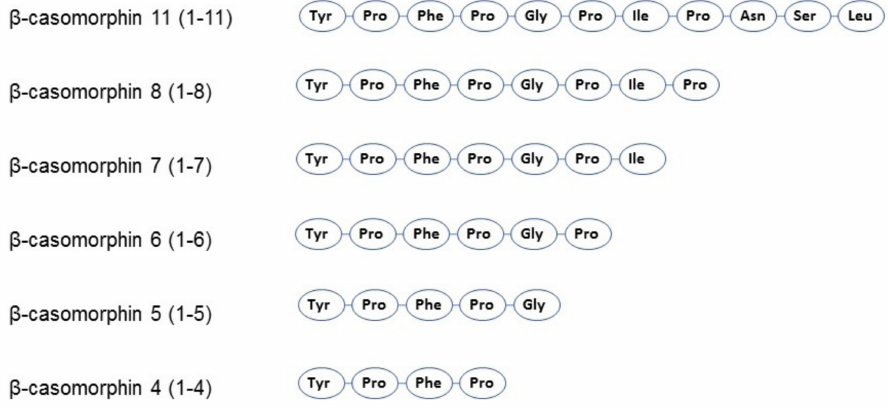
Figure 3. The amino acid composition of the β -casomorphins formed in cow’s milk (based on Ramabadran and Bansinath